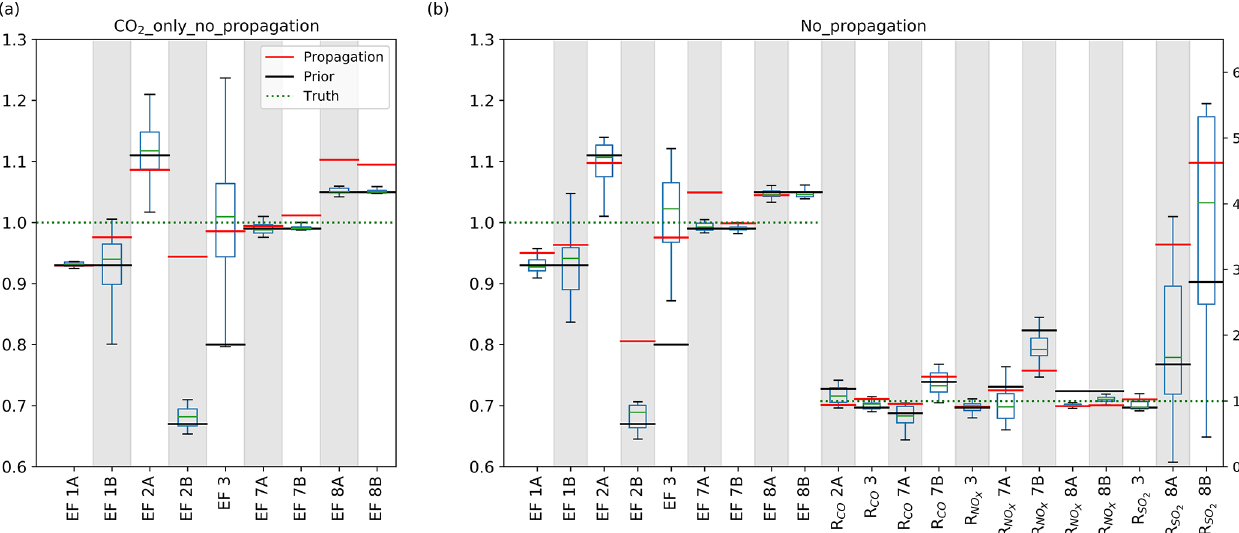
Figure 11. Spread (Q1–Q3) and median values of the parameter scaling factors for the 14 individual days included in the CO 2 _only_no_propagation (a) and No_propagation (b) inversions and final value of the CO 2 _only (a) and base (b) inversion (red lines). The prior values are indicated by the black lines and the truth is indicated with the green dotted lines (value of 1.0). The left y axis is for the emission factors and the right y axis for the tracer ratios. The inversion with all tracers shows more variability in the emission factors and larger deviations from the prior values.